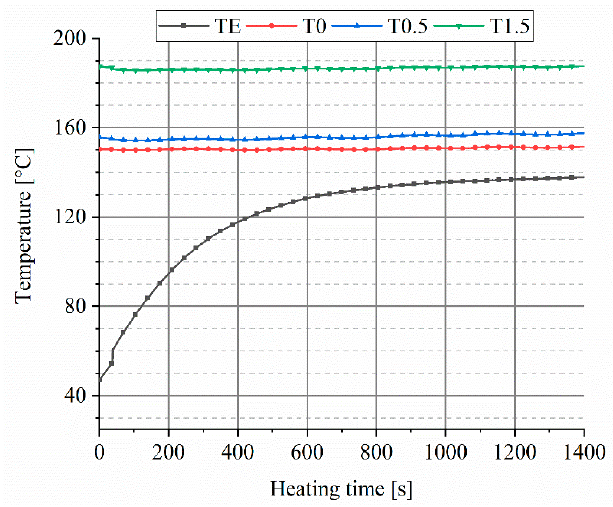
Figure 14. Heating curve of the thin film thermocouple in the plastic flat film extrusion process.